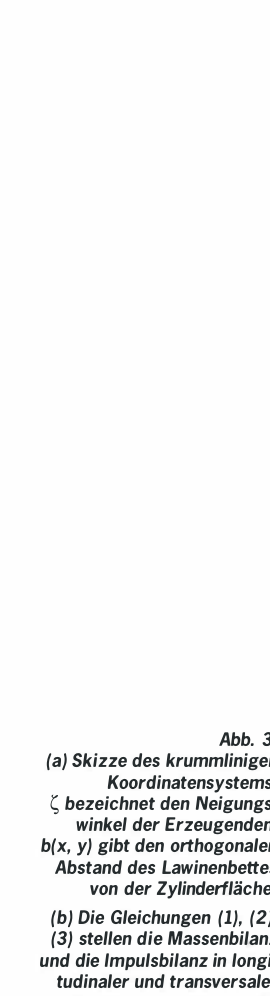
Fig. 3: (a} Schematic of the curved coordinate system. s denotes the inclination angle of the generator, b(x,y} the orthogonal distance between the avalanche bed and the cylindrical surface. (b) Equations (1}, (2}, and (3} represent the mass and momentum balances in the longitudinal and transverse directions, respectively. Equations (4} and (5} define the soil pressure coefficients in the longitudinal and transverse directions. h is the avalanche thickness, u and v are the velocity components normalized by the mean thickness, K is the local curvature of the reference surface, and A and E are scalars